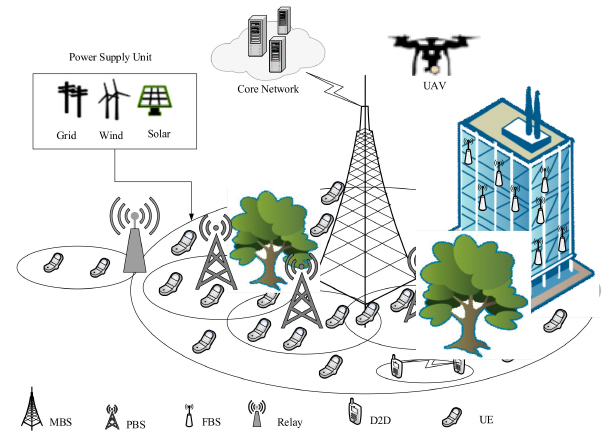
Figure 2. Heterogeneous wireless network support various wireless